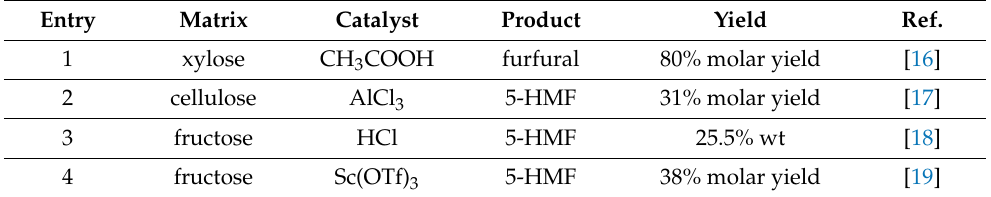
Table 1. Representative literature processes for HMF and furfural with different matrices and